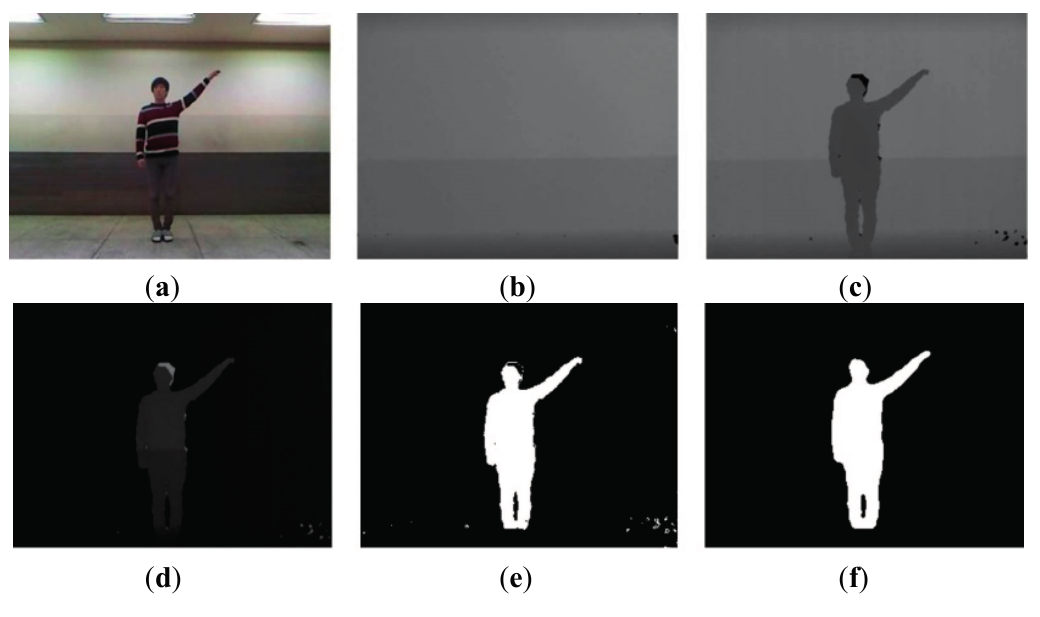
Figure 3. Color image and segmentation process images: ( a ) color image; ( b ) background image; ( c ) depth image; ( d ) difference image; ( e ) weighted binary image; and ( f ) median filter